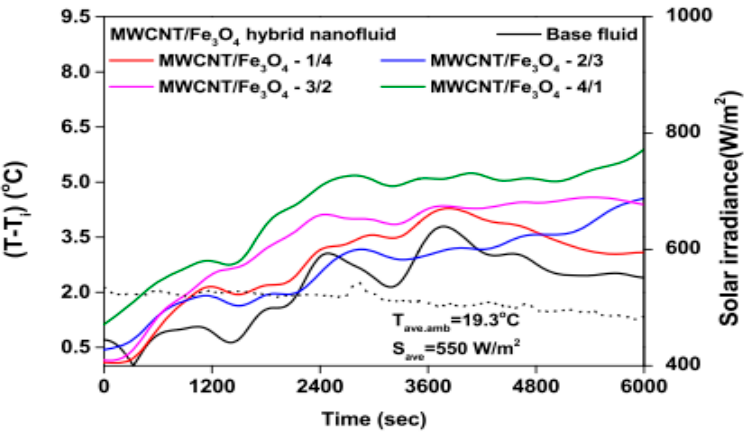
Figure 9. Temperature parameter and solar irradiance against increasing solar exposure duration for MWCNT/Fe 3 O 4 nanofluids and base fluid (Adapted from Tong et al. [61]).